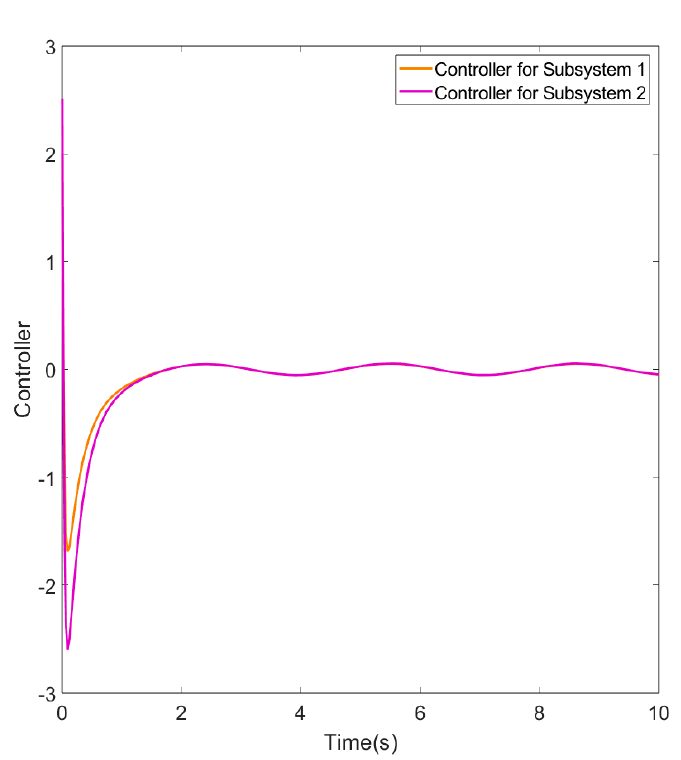
Figure 10. Responses of